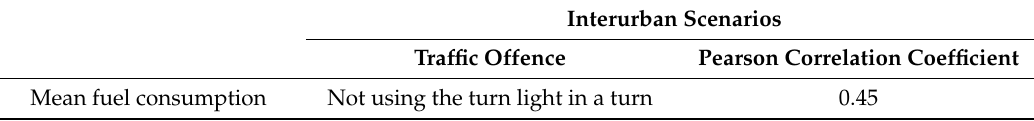
Table 4. Pearson correlation coefficients with p -value lower than 0.05 for the interurban